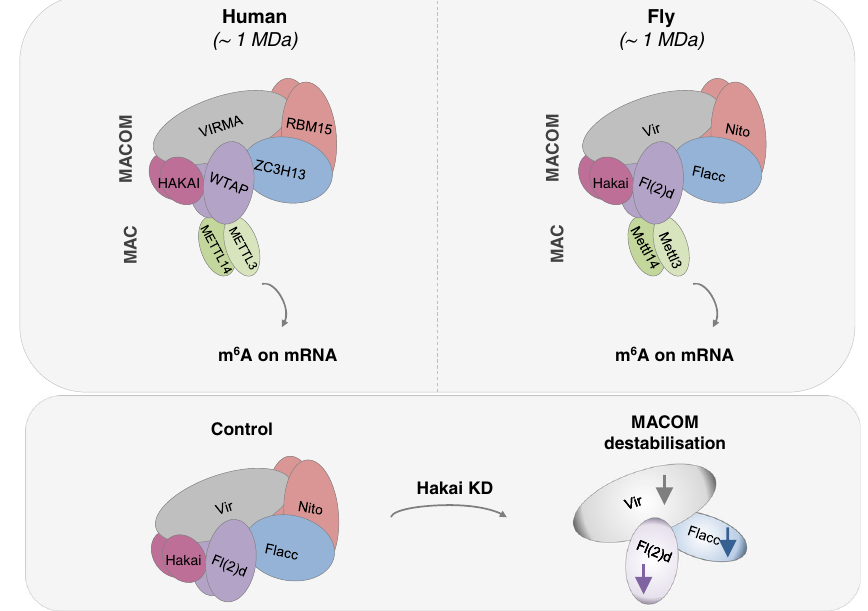
Fig. 7 Model showing the composition of the m 6 A methyltransferase complex in fl y and human and the impact of Hakai on MACOM integrity. Top left and right represent the human and fl y m 6 A methyltransferase complexes, respectively. (Bottom) The depletion of Hakai leads to a reduction in protein levels for Vir, Flacc and